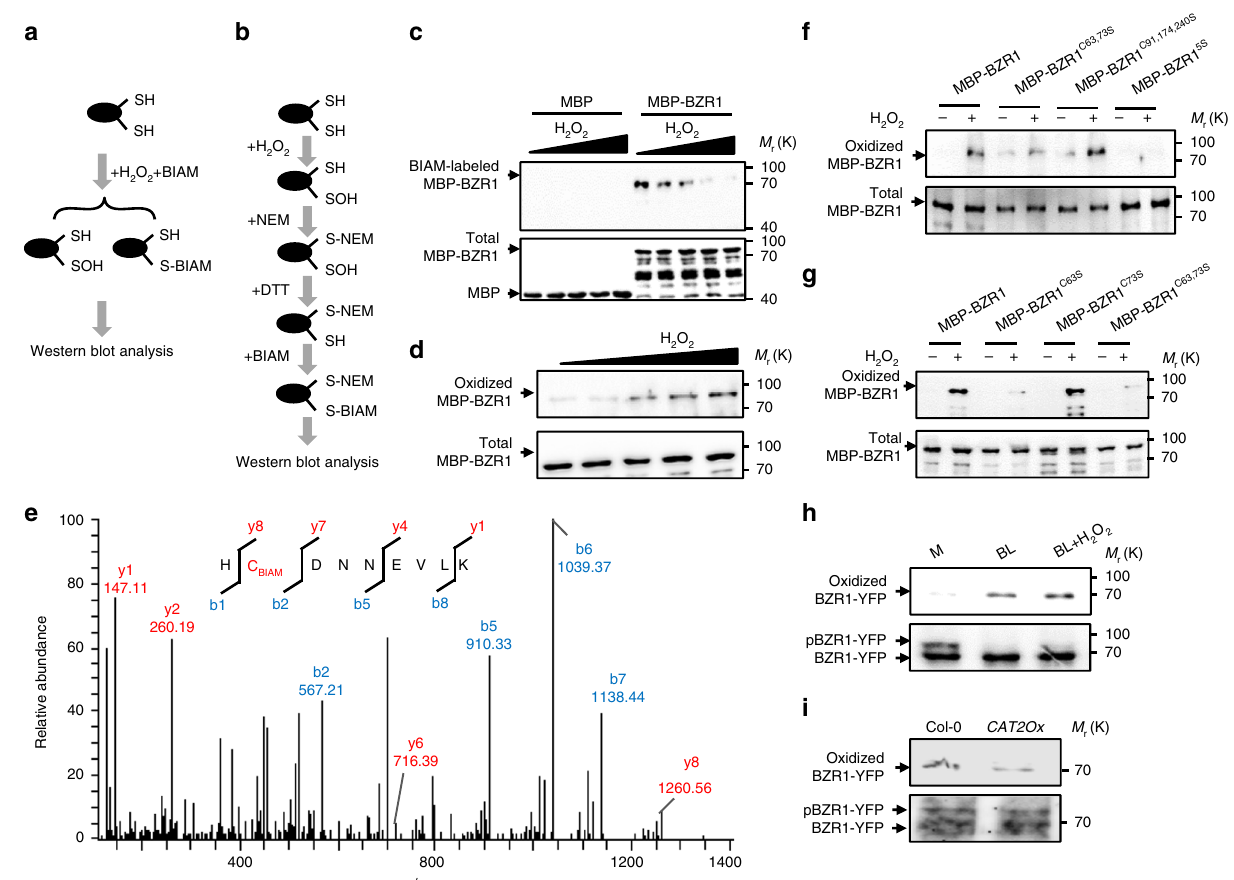
Fig. 2 H 2 O 2 induced the oxidation of BZR1 in vitro and in vivo. a , b The fl owcharts show the procedures for quantifying redox modi fi cation of target proteins by BIAM-labeling assay ( a ) and biotin-switch assay ( b ). c Analysis of the oxidative modi fi cation of BZR1 by BIAM-labeling assay. MBP and MBP-BZR1 protein were pretreated with different concentrations of H 2 O 2 , and then directly labeled by BIAM at room temperature for 30 min. The labeled proteins were subjected to separation by SDS-PAGE, and detected by gel blot analysis with HRP-conjugated streptavidin and anti-MBP antibodies. d Analysis of the oxidative modi fi cation of BZR1 by the biotin switch assay. MBP-BZR1 proteins pretreated with different concentrations of H 2 O 2 were fi rst incubated with NEM to irreversibly block the free thiols, then treated with DTT to reduce the pre-existing oxidized cysteines in MBP-BZR1. The newly exposed free thiol groups were then relabeled with BIAM. The BIAM-tagged proteins in the samples were then captured with streptavidin beads and detected by gel blot using anti-MBP antibody. e Mass spectrometry analysis of the tryptic fragments of of MBP-BZR1 protein treated as in d . Cys-63 charged with BIAM was identi fi ed as an H 2 O 2 -sensitive residue. f , g Effects of mutating various cysteine residues on the H 2 O 2 -induced cysteine oxidation in MBP-BZR1, analyzed as in d . h , i BL and H 2 O 2 treatment induced ( h ), but overexpression of CAT2 ( i ) decreased the oxidative modi fi cation of BZR1 proteins in plants. Total proteins from p35S:BZR1-YFP transgenic plants treated with or without 100 nM BL and 1 mM H 2 O 2 for 3 h, or from the p35S:BZR1-YFP/p35S:CAT2 transgenic plants were sequentially treated with NEM, DTT, and BIAM, and then analyzed for biotin analysis detected the biotin-labeled proteins. As shown in Fig. 2c,